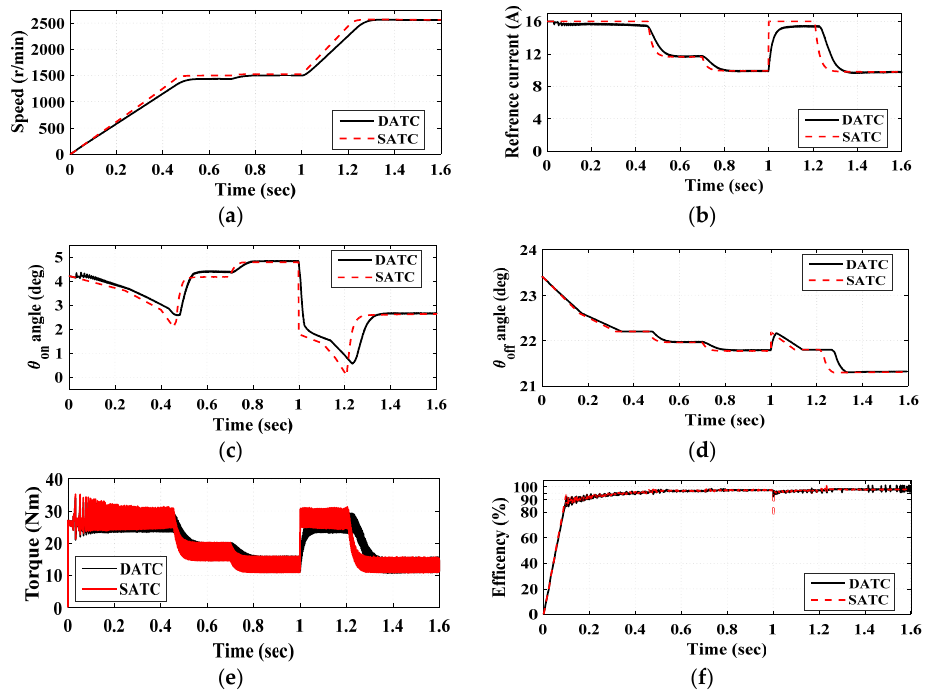
Figure 10. The simulation results with a sudden change in the load torque and reference speed: ( a ) the motor speed; ( b ) the reference current; ( c ) the variation of the turn-on angle; ( d ) the variation of the turn-off angle; ( e ) the total electromagnetic torque; ( f ) the efficiency. Mathematics 2020 , 8 , x FOR PEER REVIEW